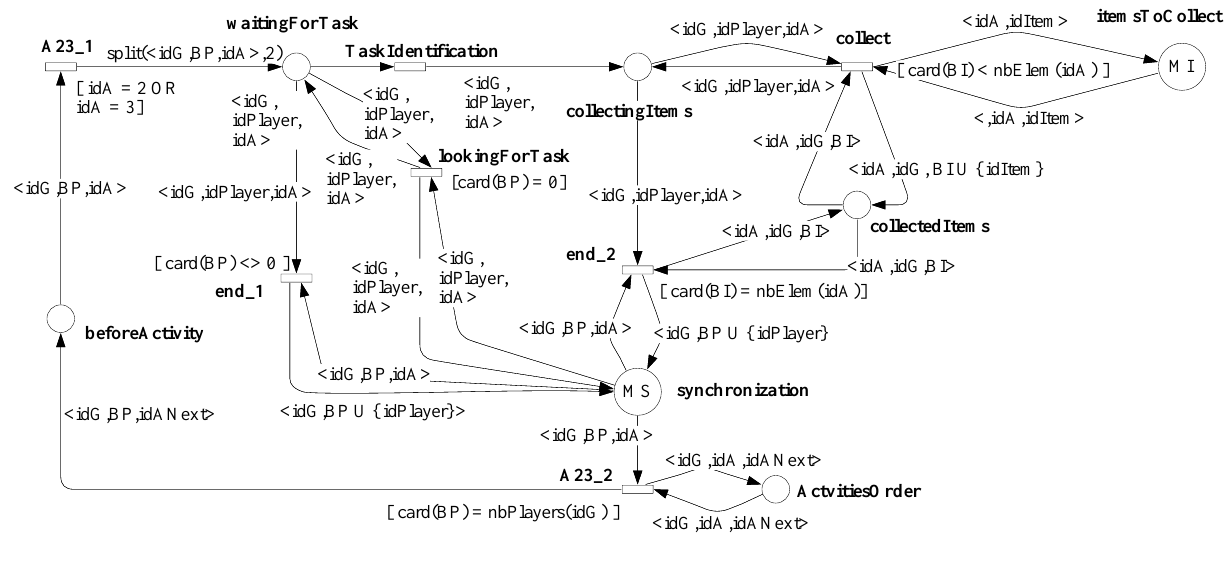
Figure 8. Collaborative activities A